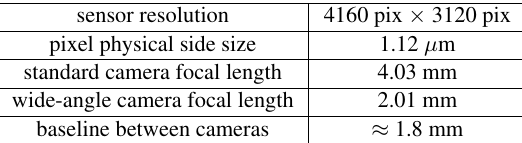
Table 1. LG G6 characteristics)